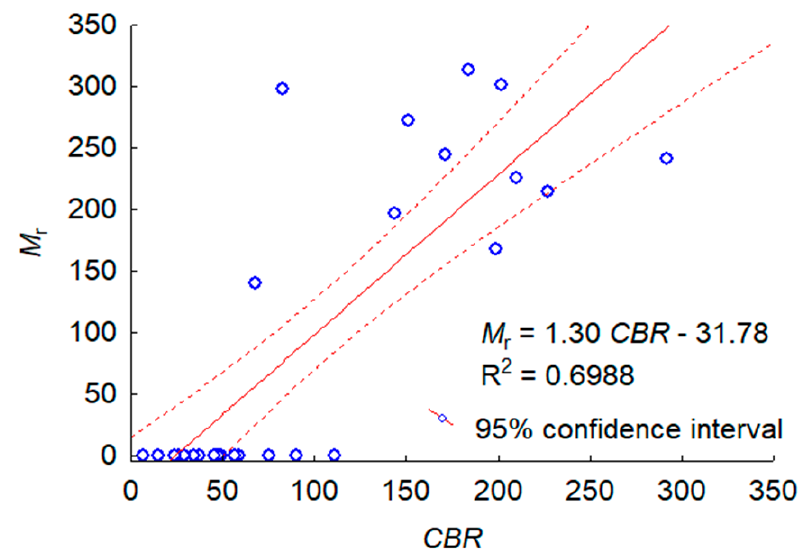
Figure 8. M r values vs. CBR values obtained for all tests along with 95% confidence intervals. Figure 8. 𝑀 values versus CBR values obtained for all tests along with 95% confidence intervals. (cid:3045) The relationship of M r = f ( CBR ) found for the bound samples with the 1.5% cement addition is statistically invalid, i.e., cyclic and static material stiffnesses are independent, so = 𝑓(𝐶𝐵𝑅(cid:4667) found for all data sets, although assessed as being The relationship of 𝑀 M r = f ( CBR ) should also not be (cid:3045)